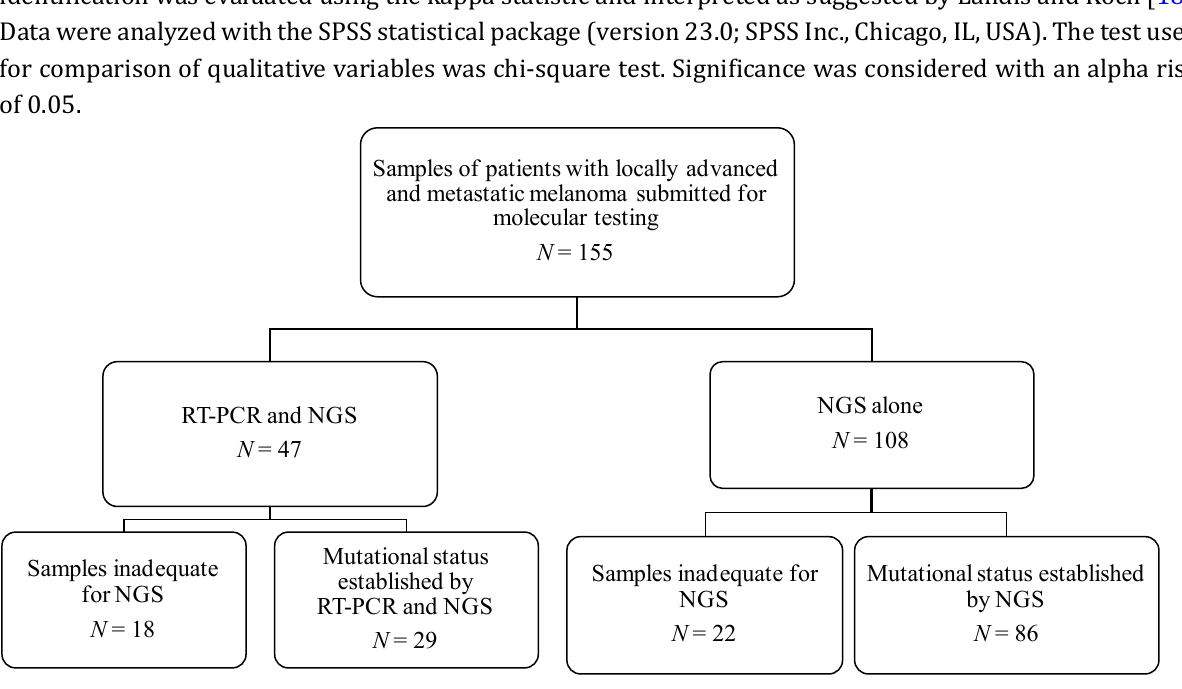
Figure 1 . Flow chart of the patient